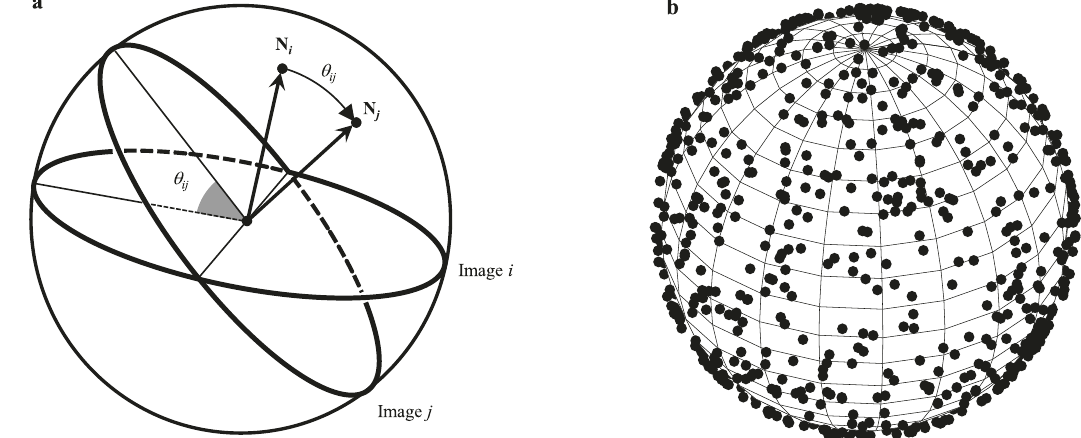
Fig. 8 Illustration of the normal vectors and their intersection points on a unit spherical surface. a The angle between the normal vectors of two images equals to their dihedral angle in the 3D reconstruction space. N i and N j are the intersection points of the normal vectors of image i and image j , respectively, on the unit spherical surface. The distance between N i and N j on the unit spherical surface equals to the dihedral angle θ ij . b The spherical embedding of 1000 intersection points of the normal vectors on a unit spherical